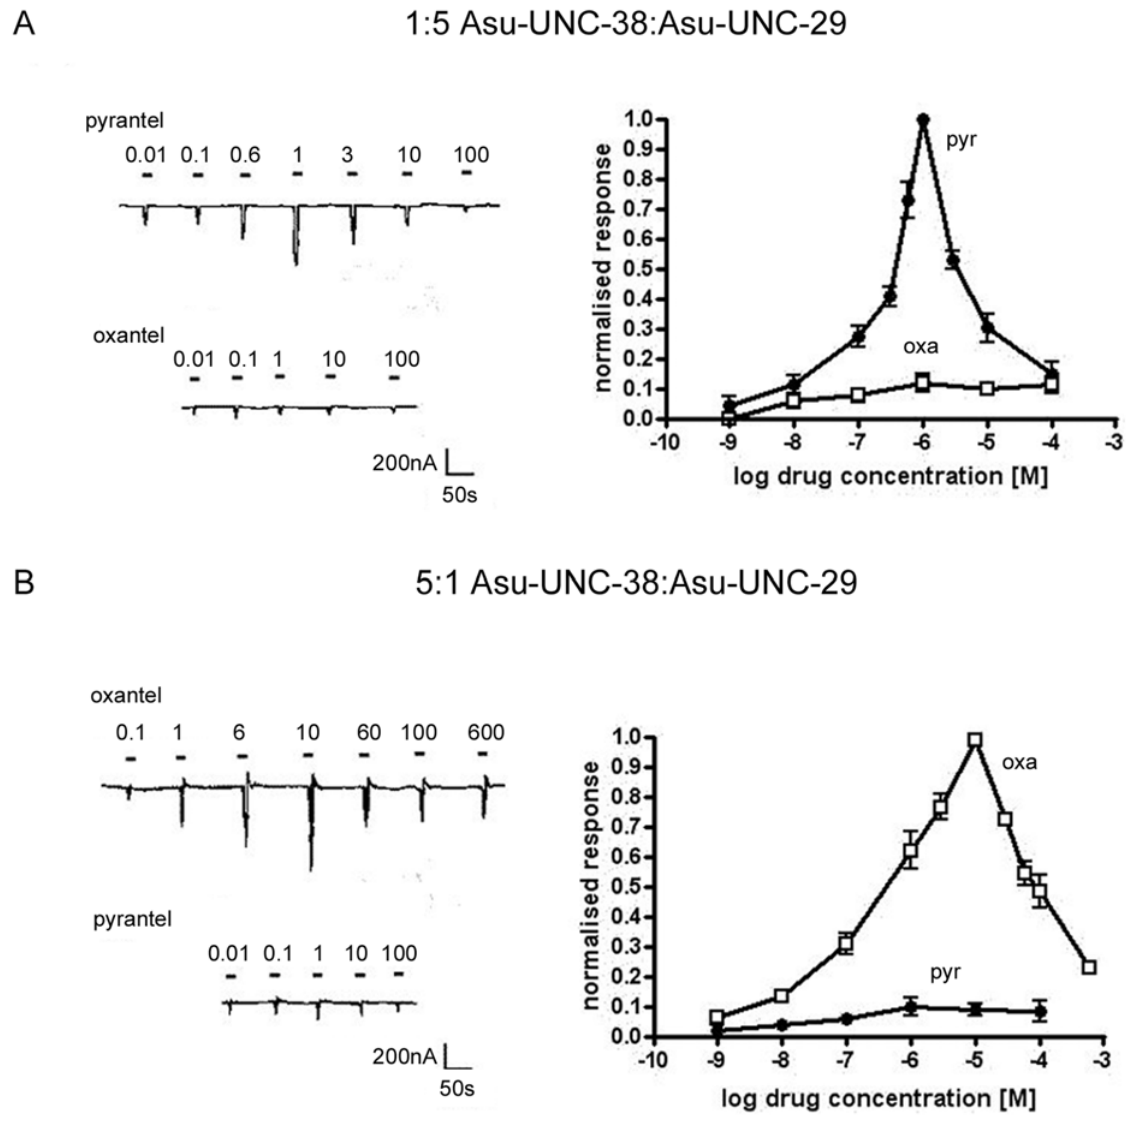
Figure 5. Responses to the anthelmintics pyrantel and oxantel. A) Electrophysiological recording from an oocyte injected with a 1:5 Asu-unc- 38:Asu-unc-29 ratio in response to the application of pyrantel (upper trace) and oxantel (lower trace). Pyrantel clearly acts as an agonist at lower concentrations ( , 1 m M) and a channel block effect reduces the response seen at higher concentrations; in comparison to this oxantel only produced small currents at any concentration. Agonist application is indicated by a bar above the trace and the concentrations are given in m M. The dose- response relationships for pyrantel and oxantel from oocytes injected with a 1:5 ratio of Asu-unc-38 and Asu-unc-29 are shown: N=3 n=6 minimum for each data point. All responses were normalized to the maximal response (i.e. to the response to 1 m M pyrantel), which was comparable to the response to 100 m M acetylcholine (not shown). B) Electrophysiological recording from oocytes injected with a 5:1 Asu-unc-38:Asu-_unc-29 ratio in response to the application of oxantel (upper trace) and pyrantel (lower trace). Oxantel clearly acts as an agonist at lower concentrations ( , 10 m M) and a channel block effect reduces the response seen at higher concentrations; in comparison to this pyrantel only produced small currents at any concentration. Agonist application is indicated by a bar above the trace. Agonist concentrations and the concentrations are given in m M. The Dose- response relationships for pyrantel and oxantel from oocytes injected with a 5:1 ratio of Asu-unc-38 and Asu-unc-29 are based on N=3 n=6 minimum for each data point. All responses were normalized to the maximal response (i.e. to the response to 10 m M oxantel), which was comparable to the response to 100 m M acetylcholine (not shown).